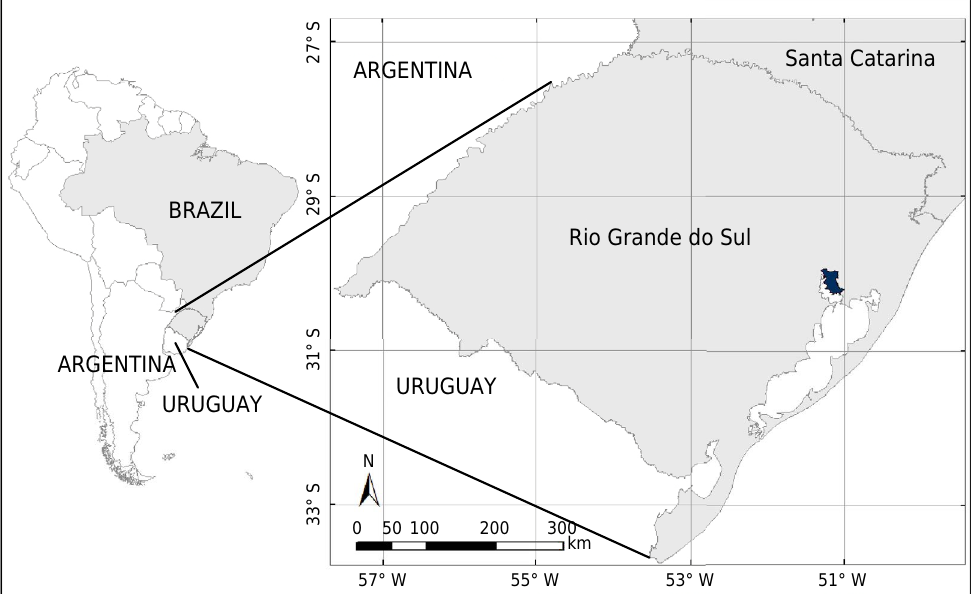
Figure 1. Location of the study area in the state of Rio Grande do Sul,